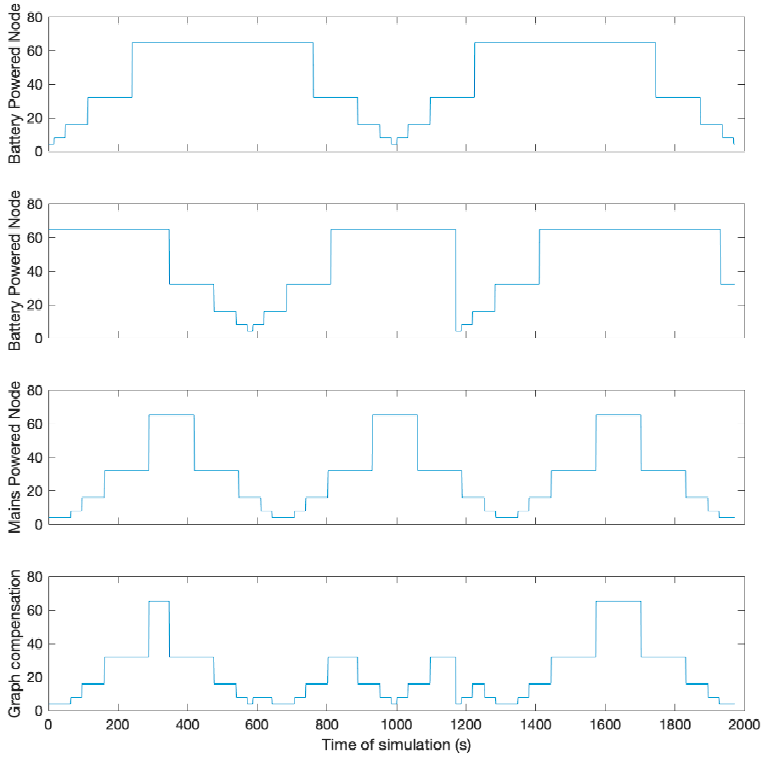
Figure 7. Compensation between nodes of the beacon transmission mechanism.